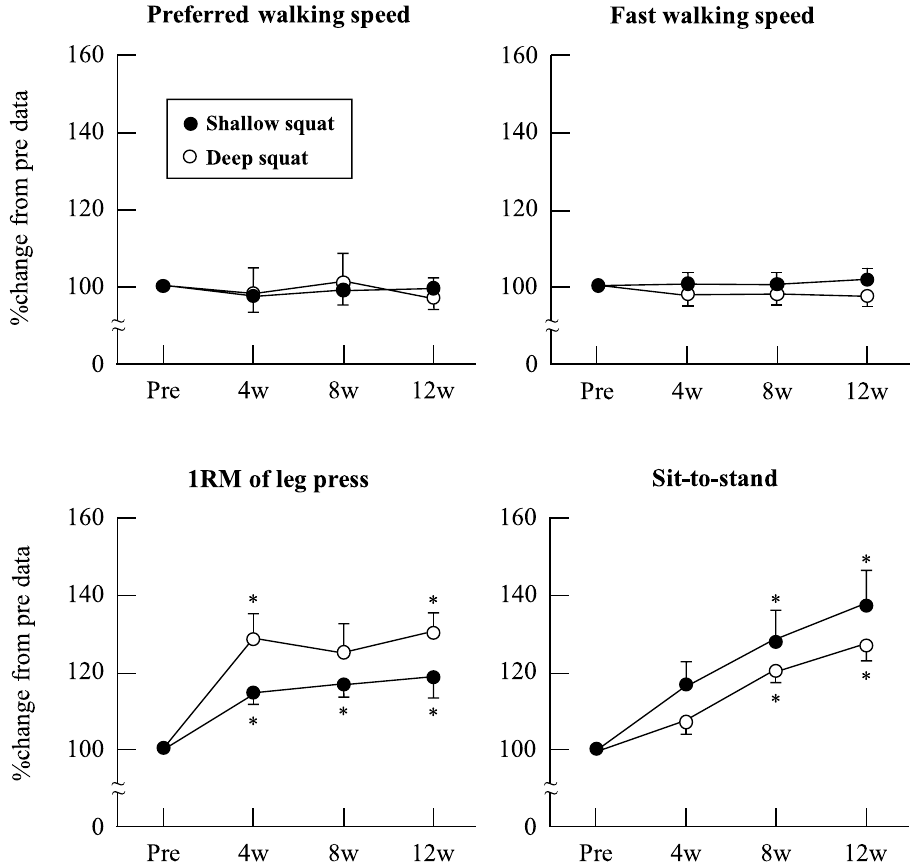
Figure 4. Relative changes in physical functional test results as a consequence of squat training in the shallow squat and deep squat groups. Error bars show standard error (SE). * P < 0.05 vs.